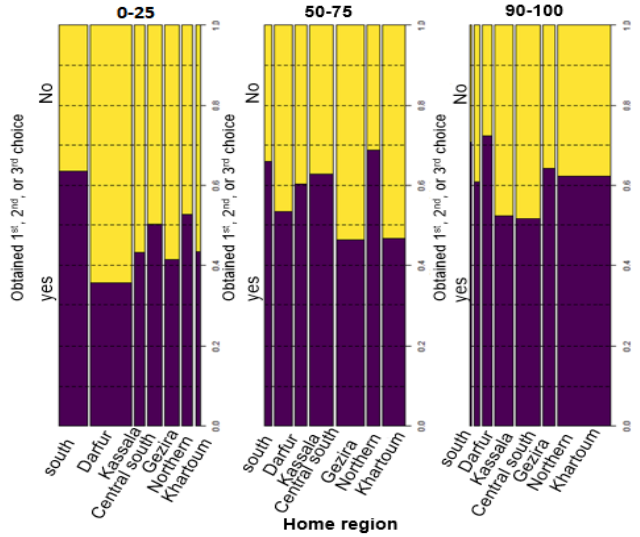
Figure 16. Percentage of bachelor’s (2016–2017) applicants receiving first, second, or third choice by home region for different rank percentile ranges (0–25%, 50–75%,